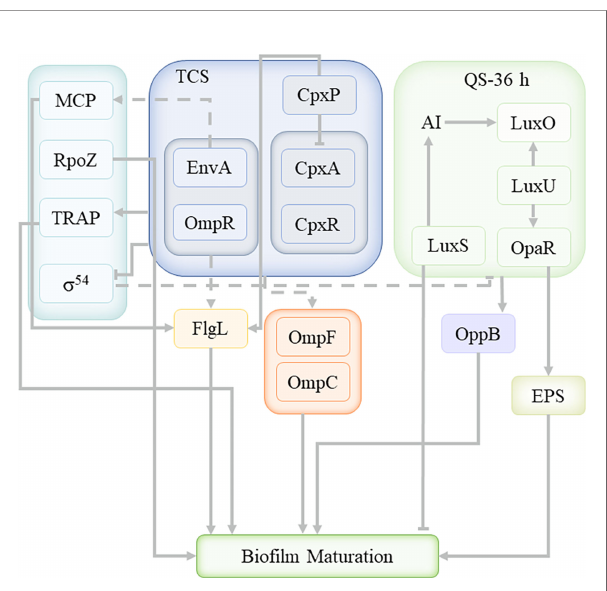
FIGURE 8 | The transcriptional network of V. parahaemolyticus bio fi lm formation in 36 h.